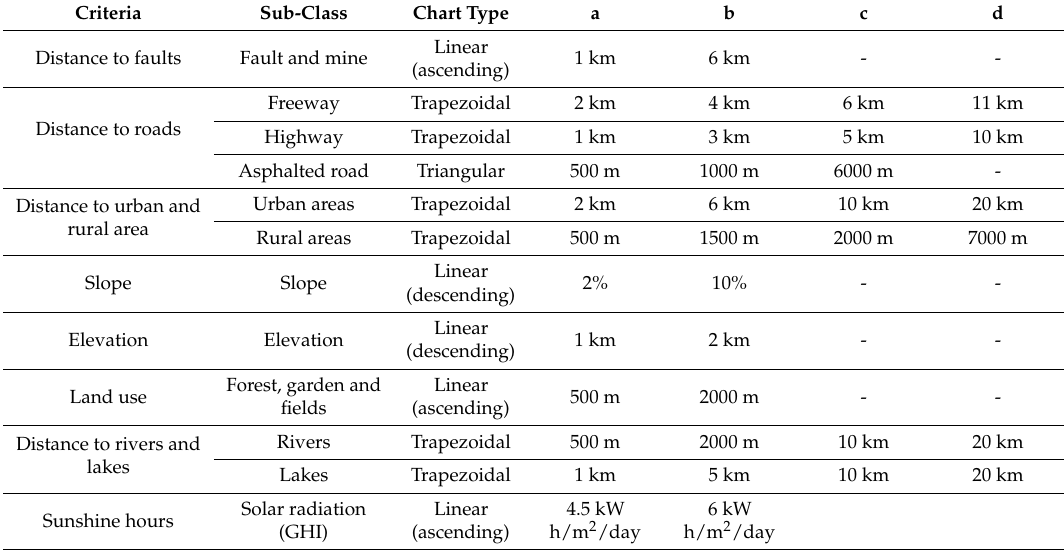
Table 3. Determined values to specify the required variables of fuzzy membership functions (the factor maps of this table are illustrated in Figure